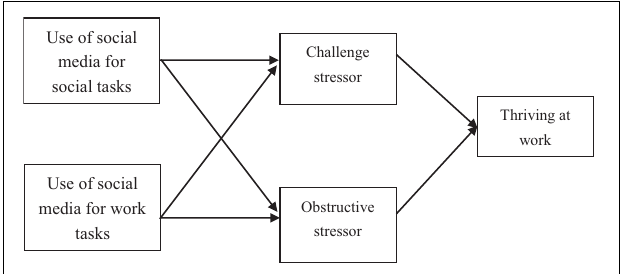
FIGURE 1 | The relationship between social media usage and thriving at